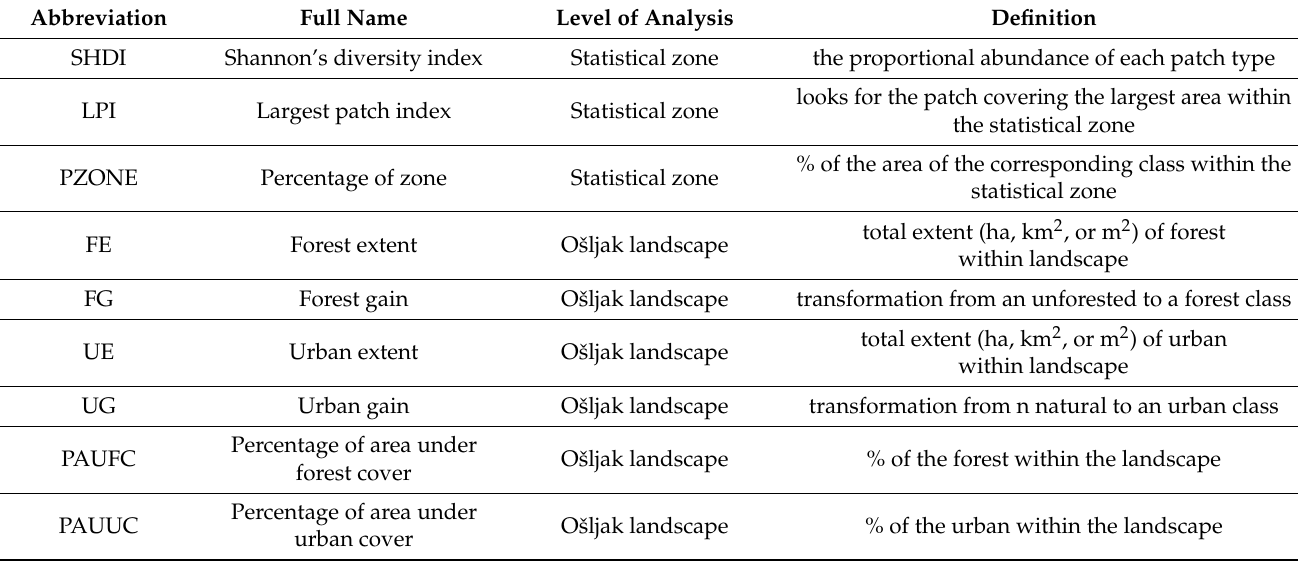
Table 4. List of metrics used in LUCC